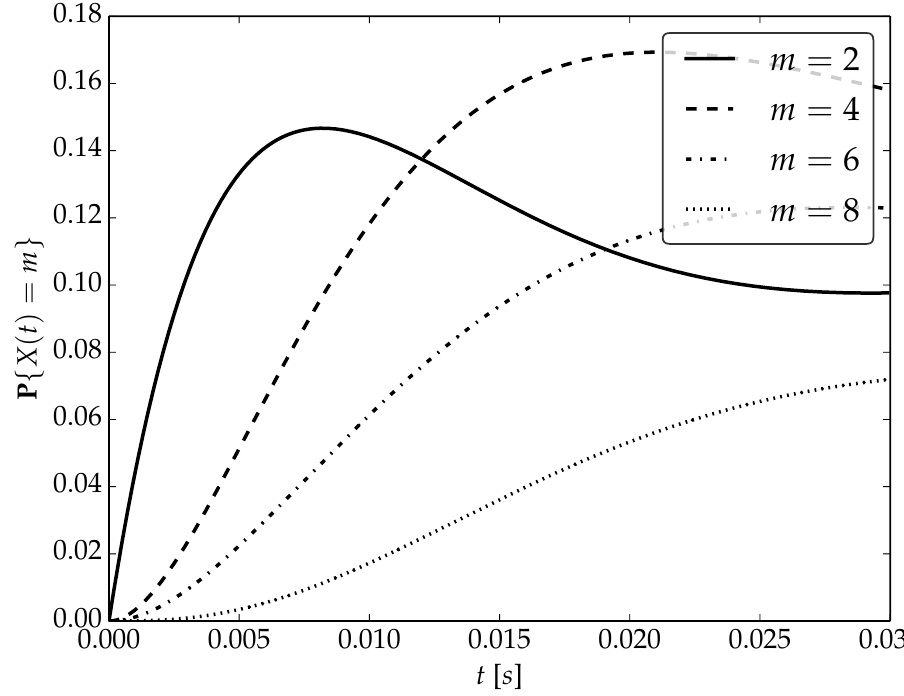
Figure 11. Transient distributions P { X ( t ) = m } for N = 6, batch distribution P 2 and ρ =